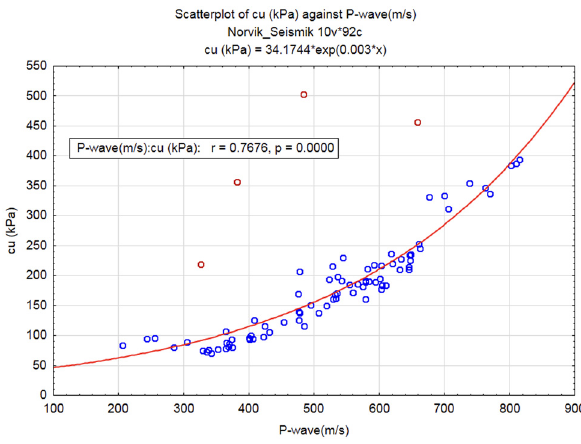
Figure 6: Shear strength as a function of P - wave velocity with red circles indicating identi fi ed outliers.